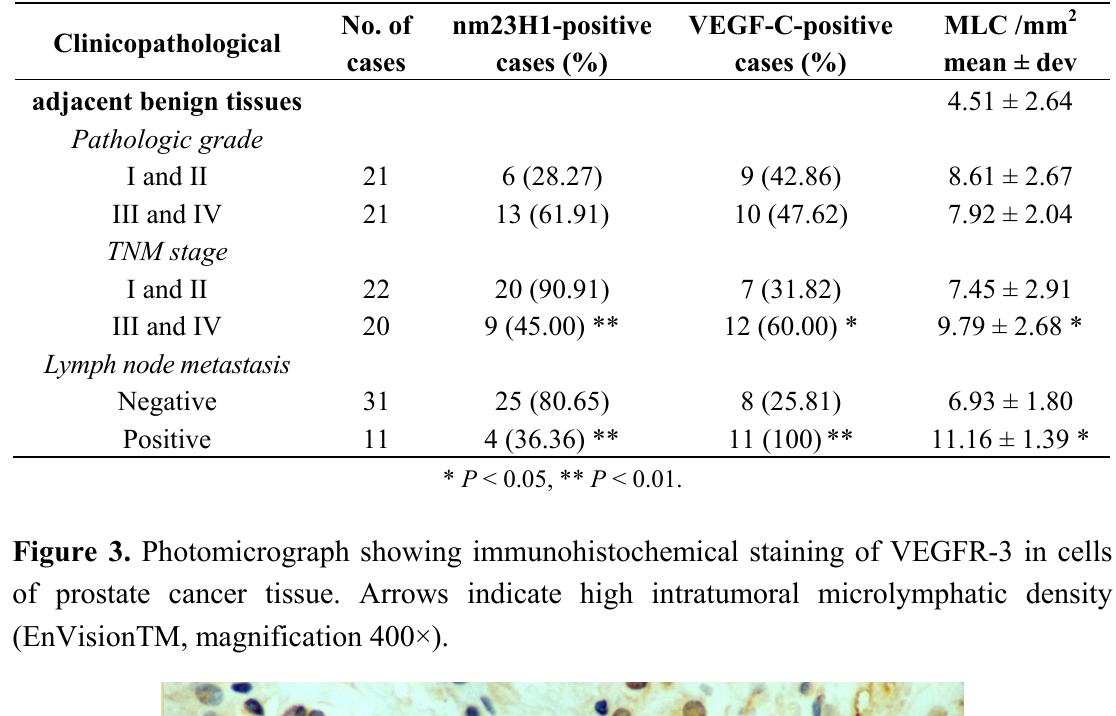
Table 2. Relationship between nm23H1, VEGF-C, MLC, and clinicopathology of PCa tissue.